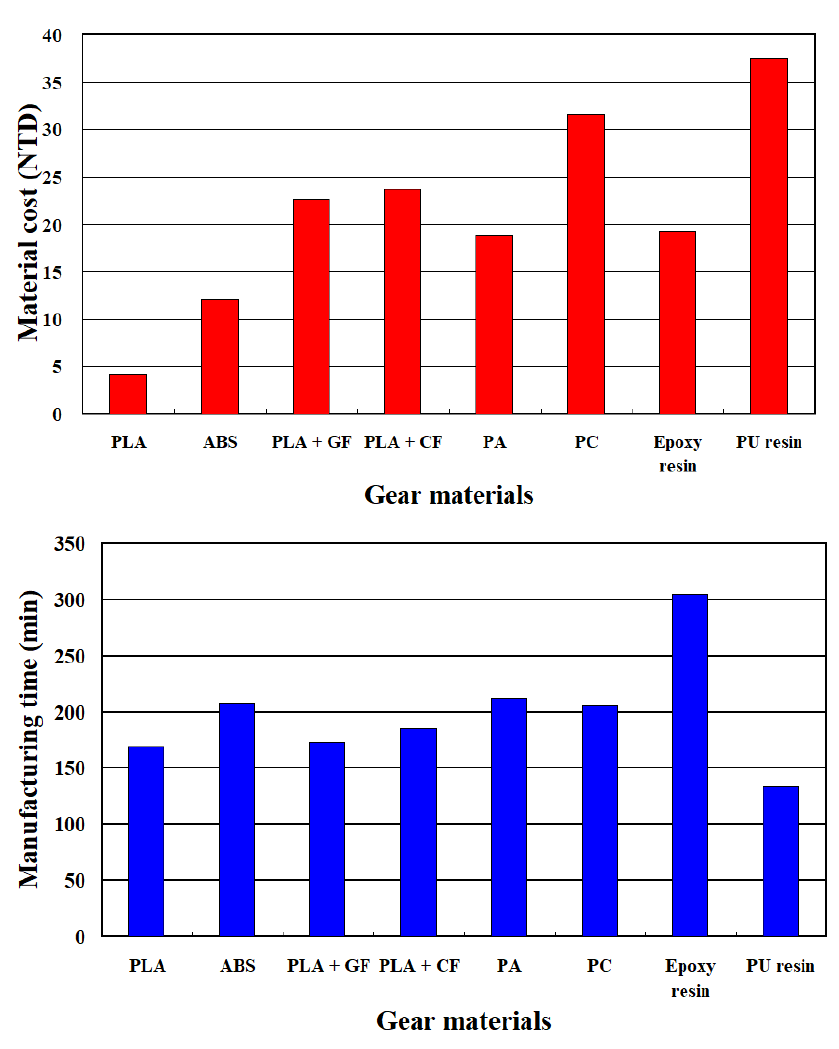
Figure 20. Materials cost and manufacturing time for gears fabricated with eight different materials.